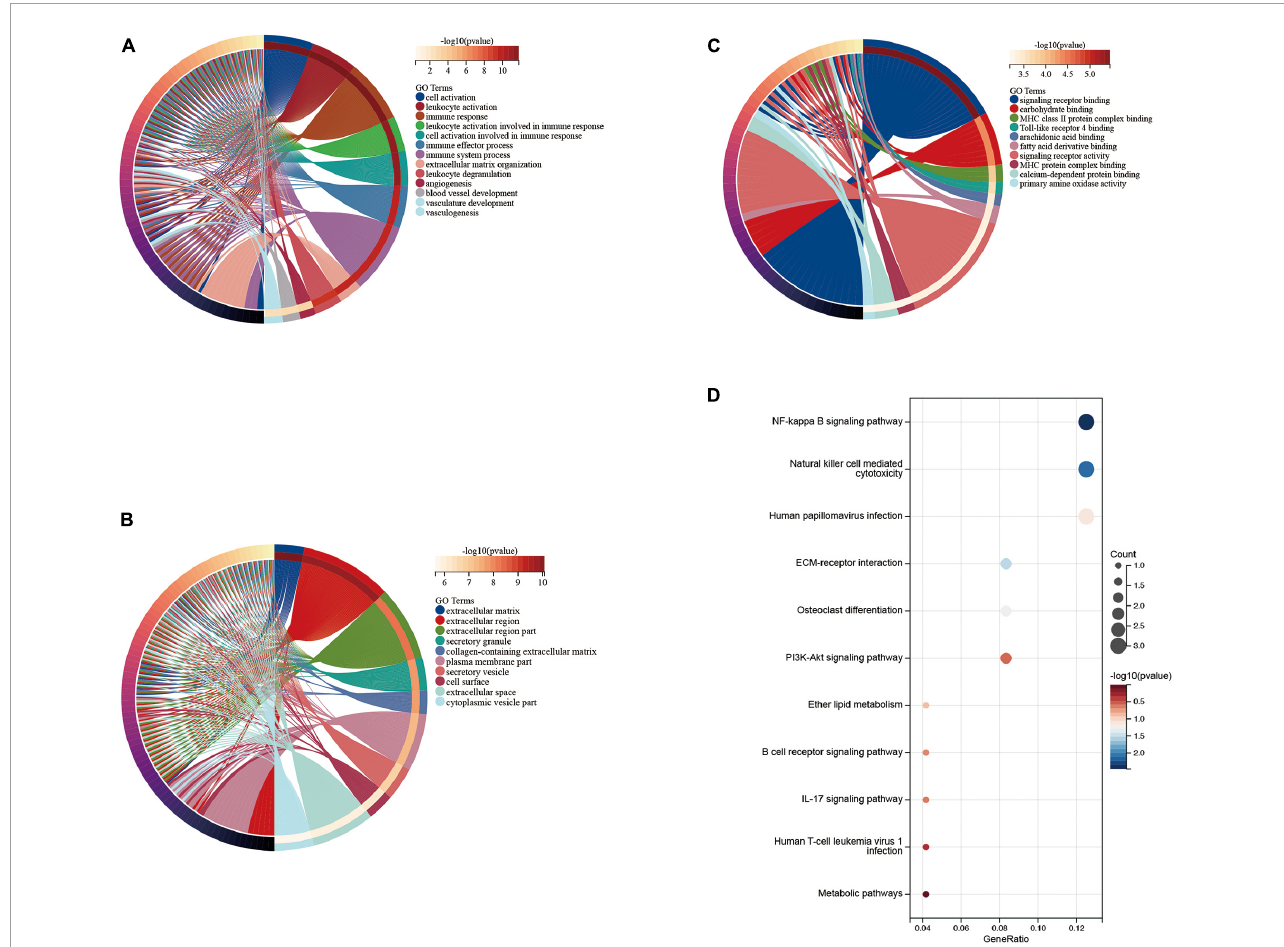
FIGURE4 Enrichment analysis of disease genes. Gene Ontology (GO) (A) biological process, (B) cellular component, (C) molecular function, Kyoto Encyclopedia of Genes and Genomes (KEGG) (D) enrichment analysis.